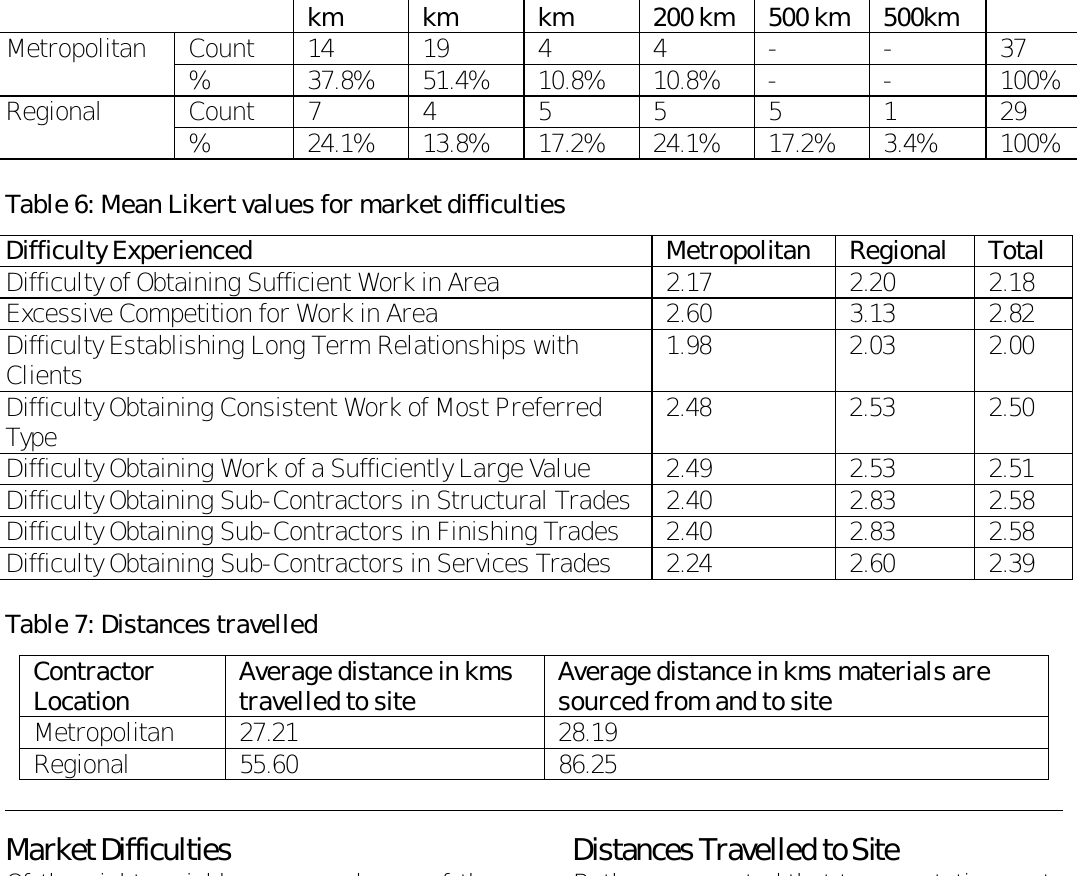
Table 5: Average distance travelled to training facilities Contractor Location